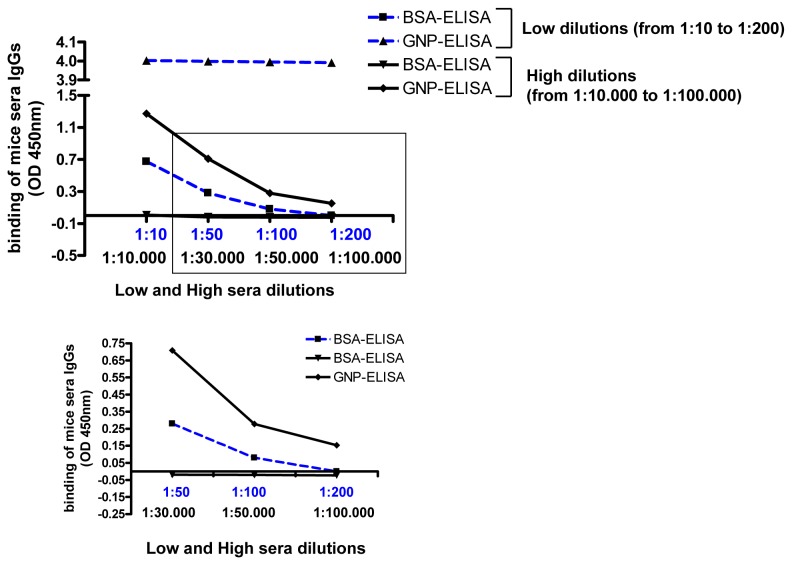
Direct comparison between BSA-ELISA and GNP-ELISA for IgGs detection in mice.At low sera dilution (dotted blue lines, from 1:10 to 1:200) the BSA-ELISA (blue line, squares) gave a response from 0.7 to 0.1 OD, while the GNP-ELISA (blue line, triangle) gave a saturated response around 4 OD. At high sera dilution (dark lines, from 1:10.000 to 1:100.000) the BSA-ELISA (dark line, reverse triangle) was no able to detect IgGs (OD around zero), while the GNP-ELISA (dark line, rhombus) detected IgGs (OD from 1.4 to 0.3) up to 1:50.000 diluted sera.